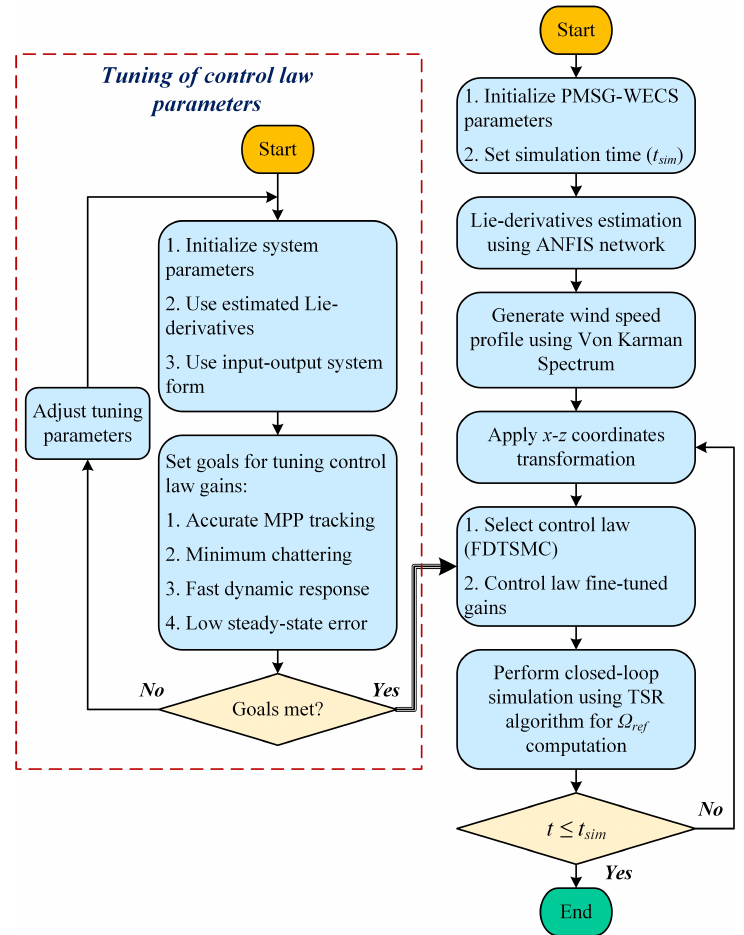
Figure 4. Computational flow chart for implementation of the proposed MPPT